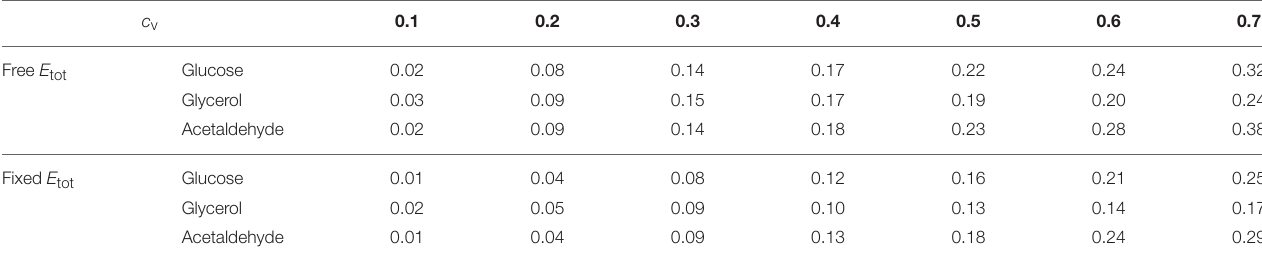
TABLE 3 | Mean of positive H BP values ( H + BP ) for the glucose, glycerol and acetaldehyde fluxes over the range of c v values. c